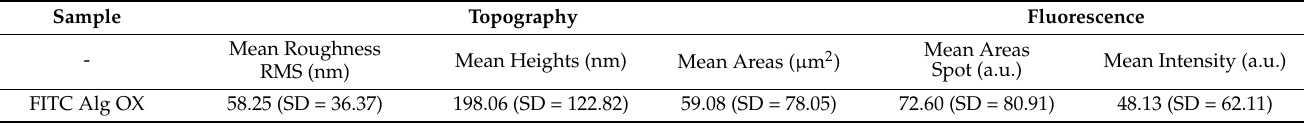
Table 3. Statistical analysis of FITC-AlgOX (1 mg/mL) properties according to SNOM observations.